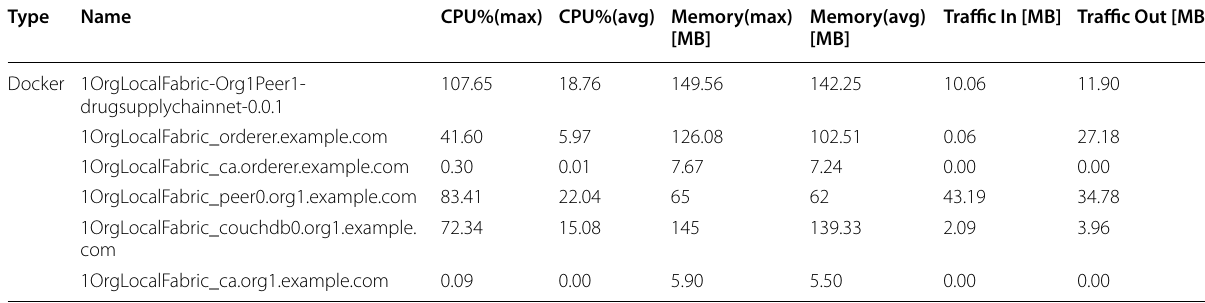
Table 2 An analysis of the proposed system’s resource utilization